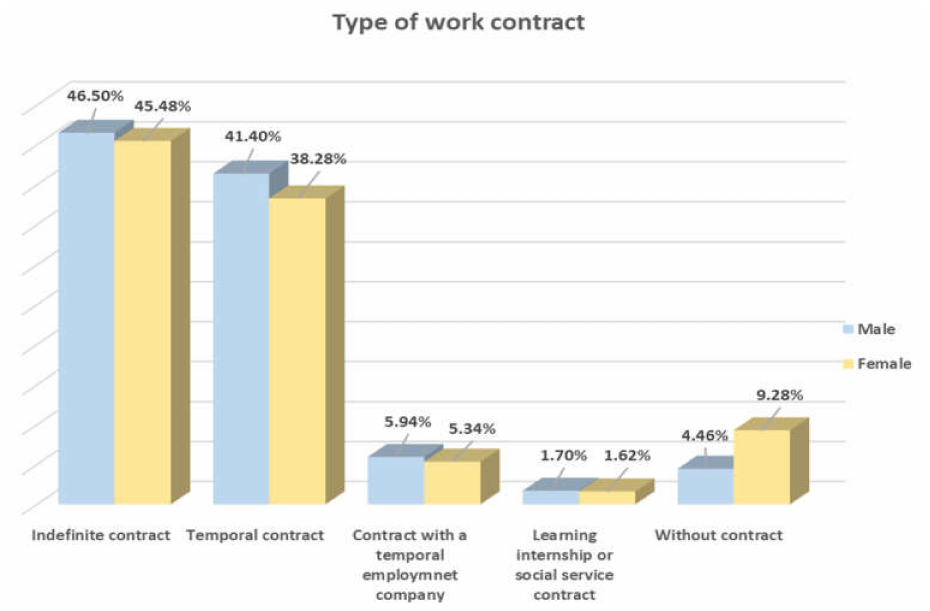
Figure 3. Contract